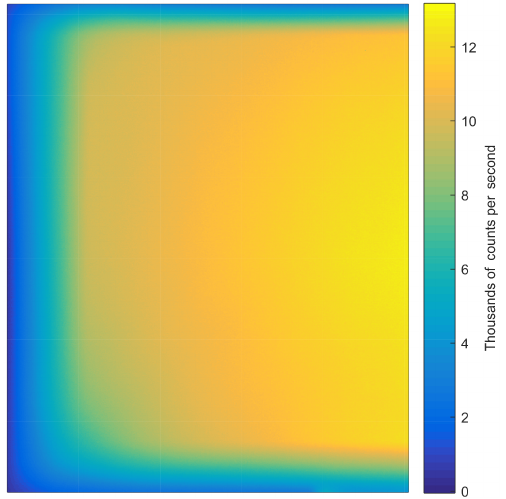
Figure 7. A calibration image after stray light removal has been performed where the measured wavelength is 750nm with a 1s ex- posure time. Vignetting can be seen as moving away from centre of the image. Additionally, the last 1 ◦ of the horizontal field of view on the right side is lost due to strong contamination from reflections within the